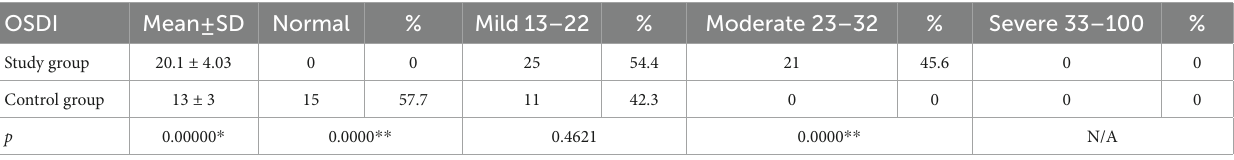
TABLE 2 OSDI mean scores and DED grades in the study and control groups.